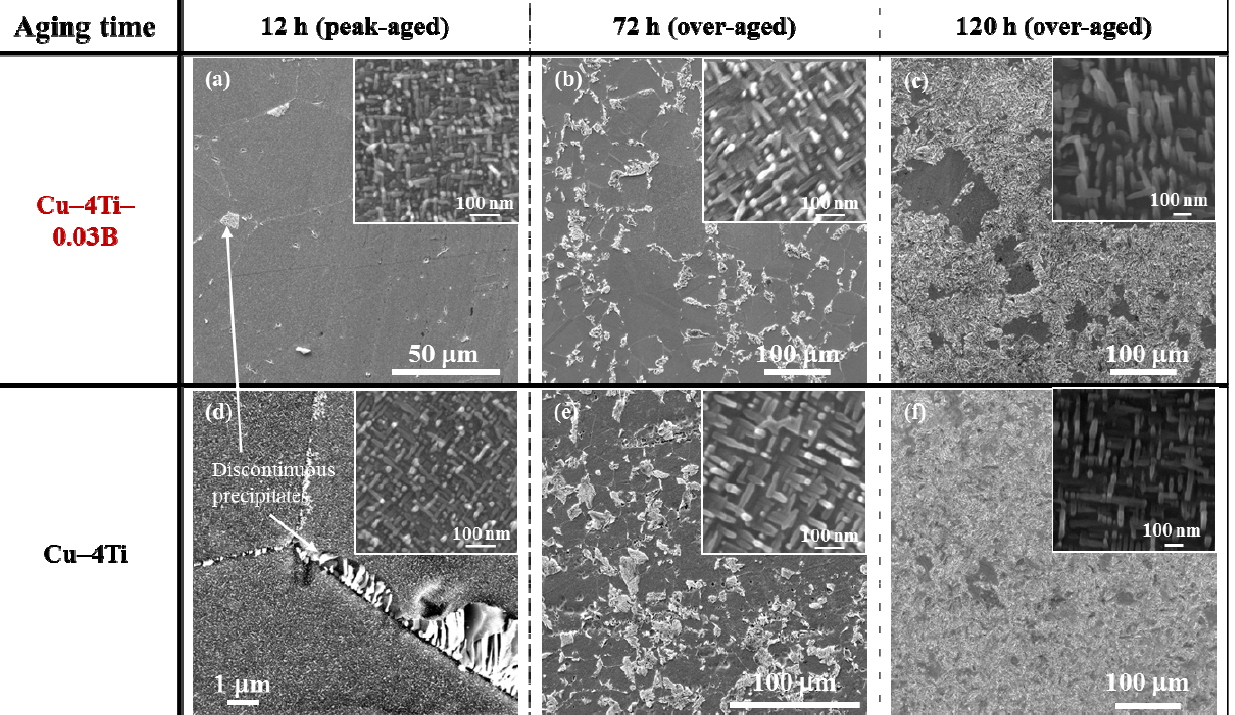
Figure 1. Elemental mapping of ( a ) Ti and ( b ) B in the solid-solution-treated Cu–4Ti–0.03B alloy, obtained by ToF-SIMS analysis. ( c ) EBSD-pattern quality map superimposed on the B map by ToF-SIMS analysis, ( b ). Note that the image in ( c ) corresponds to the region marked by the dotted rectangle in ( a ) and ( b ).